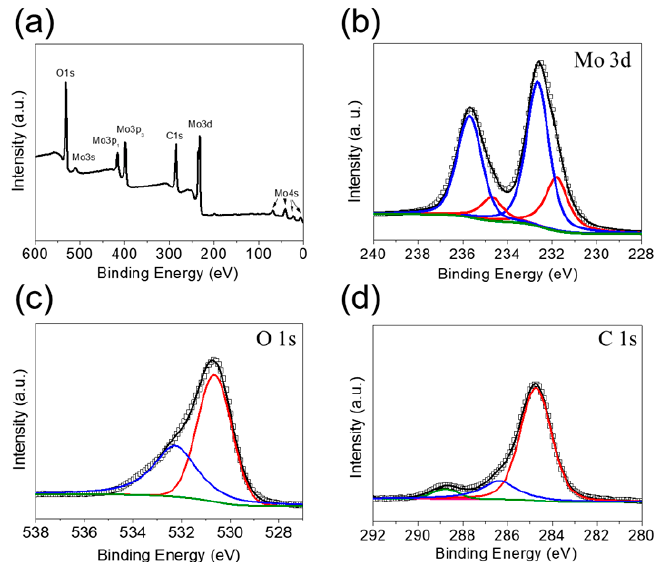
Figure 2. The XPS spectra of the MoO 3 /C composite microspheres: ( a ) the survey XPS spectrum and high-resolution XPS spectra of ( b ) Mo 3d, ( c ) O 1S, and ( d ) C 1s.